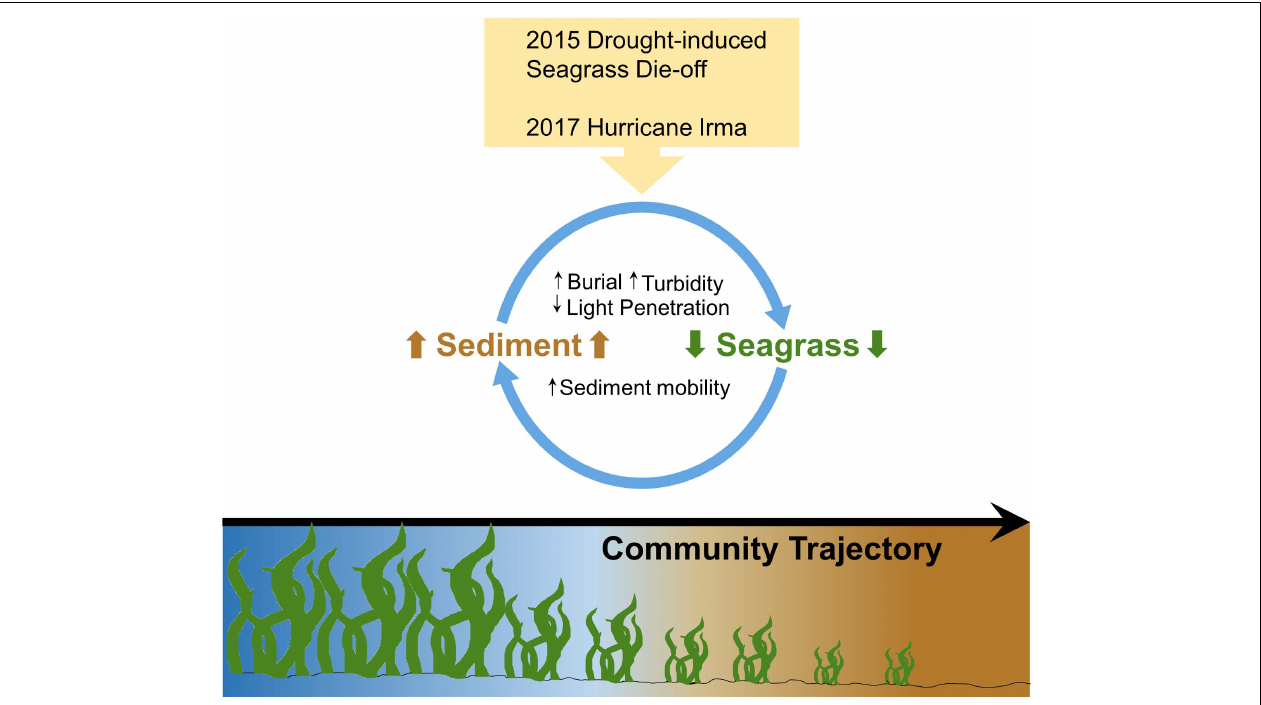
FIGURE 1 | Conceptual diagram illustrating the turbidity feedback loop within Florida Bay seagrass ecosystems. Two large disturbances (a 2015 seagrass die-off and the 2017 Hurricane Irma) caused a reduction in seagrass cover, which increased sediment mobility and thus, the amount of sediment in the water column, which in turn decreased light penetration while increasing turbidity and burial (Figure adapted from Nyström et al.,